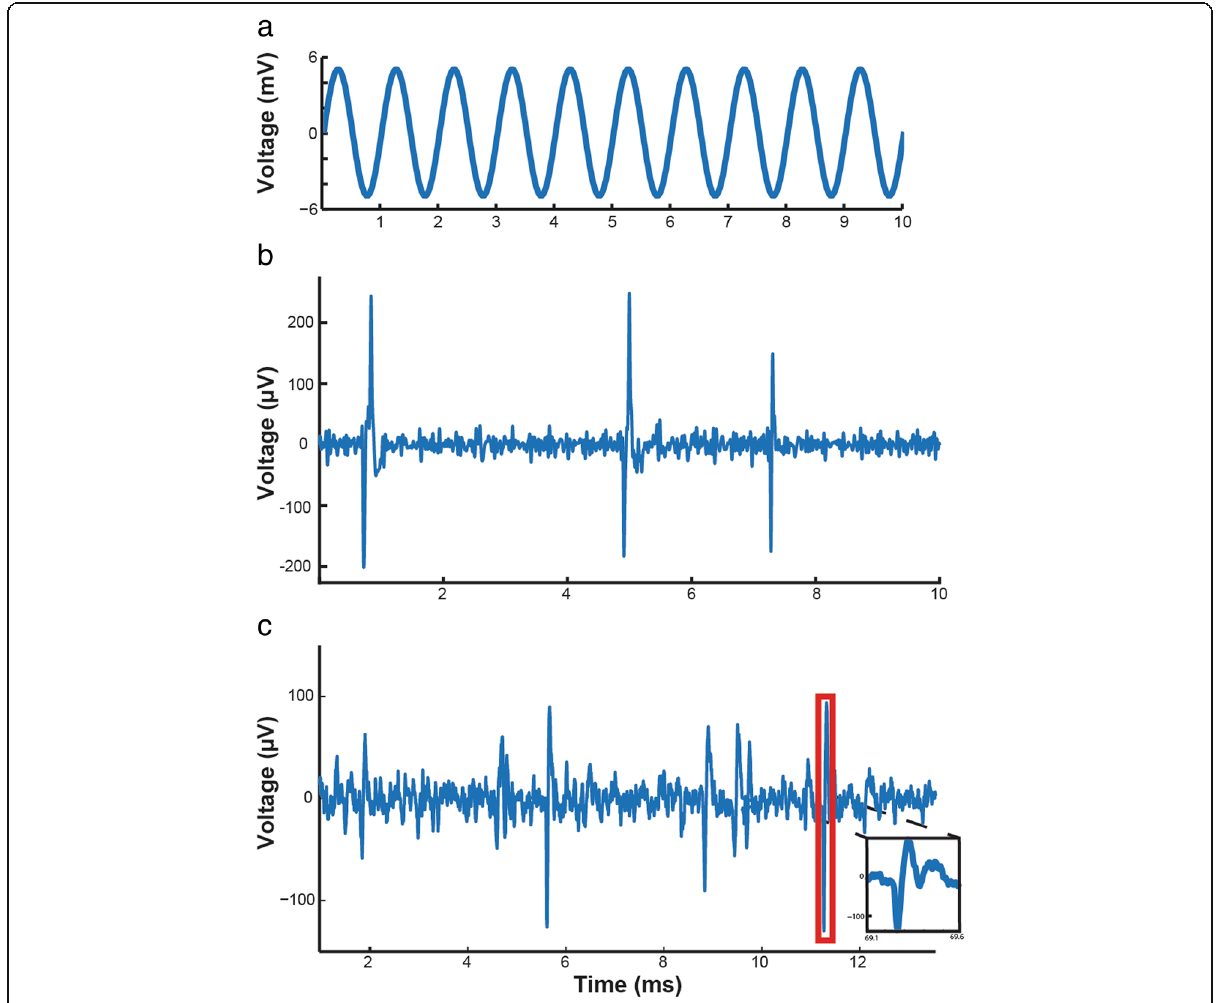
Fig. 7 Single channel data recorded through the device, sampled at 32 kSps. a 1 kHz sine wave. b Simulated neural data from neural signal generator (Blackrock Microsystems). c Pre-recorded neural data from rhesus